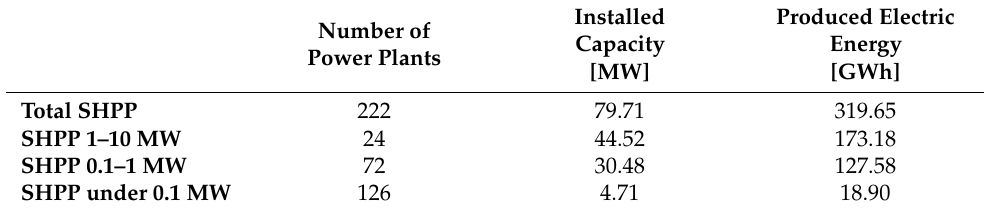
Table 1. Numbers of SHPP, energy production, and size distributions in the Slovak Republic (2021) [17].